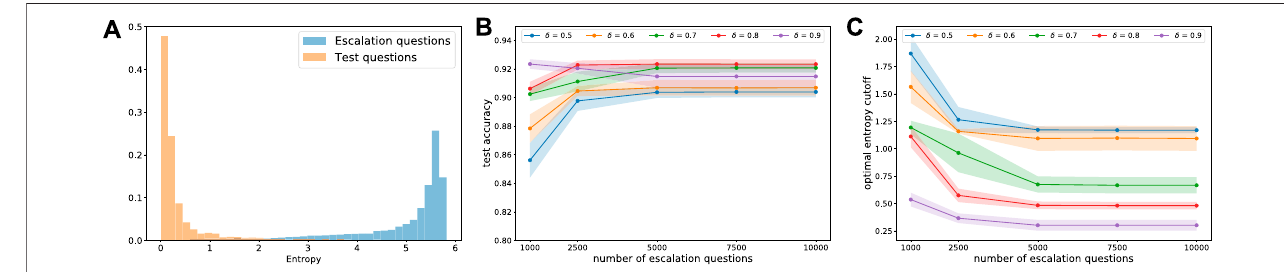
FIGURE3| Optimizingtheentropythresholdtodetectescalationquestions.Asshownin (A) ,in-sampletestquestionsandescalationquestionshaveverydifferent distributions of predictive entropies. Sub fi gure (B) shows how test accuracies, evaluated using decision variables b solved by (1) on BERT predictions on test data, change when different numbers of escalation questions are involved in training. Sub fi gure (C) shows the impact of δ on the optimized thresholds when the number of escalationquestionsincreaseoptimization.Usually,tosafeguardmakingwrongpredictionsinclient-facingapplications, δ issettoavaluesmallerthan1because1 means the cost of making wrong predictions is the same as spending human effort on a question. In contrast, a value 0.5 means the cost of wrong predictions is two times larger than human answering cost. Such a cost is guided by business reasons, and different δ could lead to different optimal